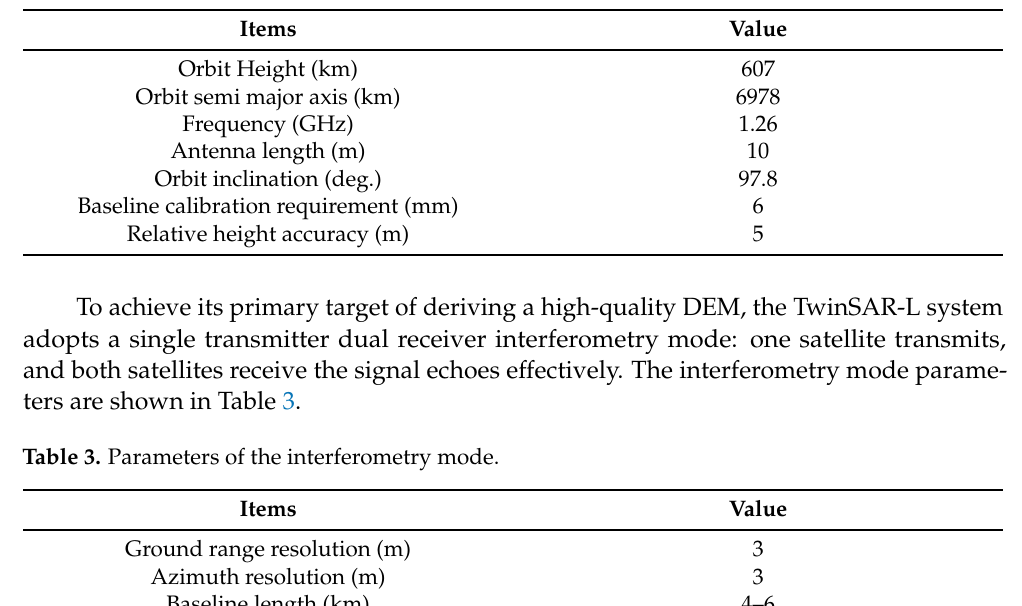
Table 2. Parameters of the TwinSAR-L system.